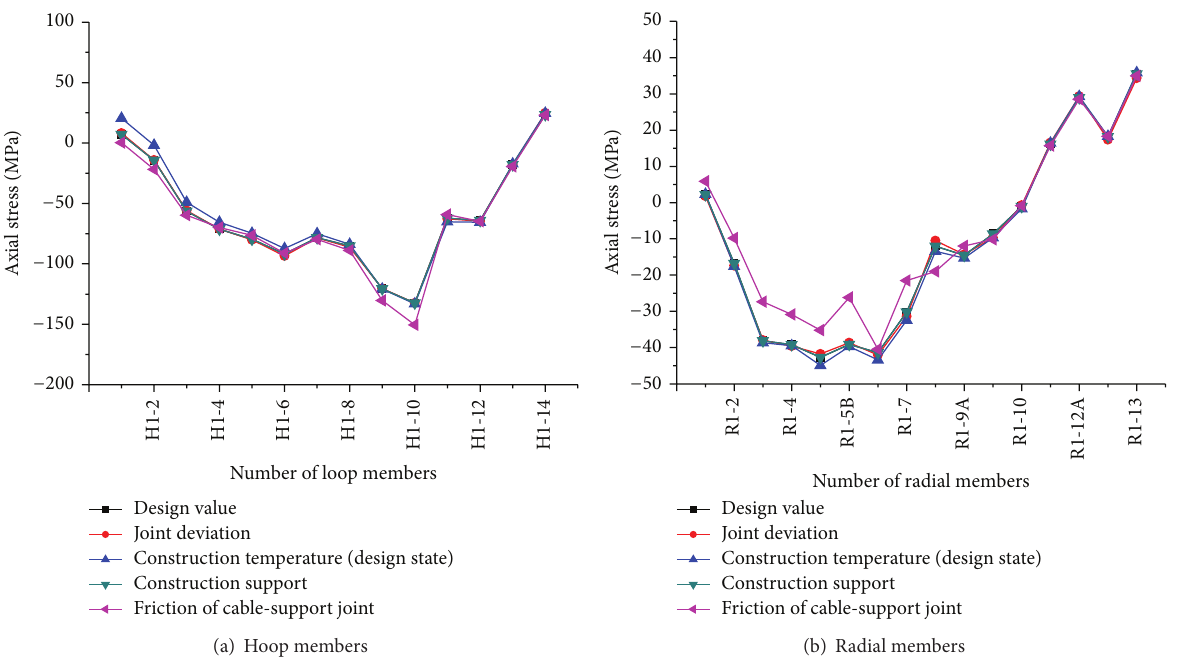
Figure 11: Axial force of members on the upper